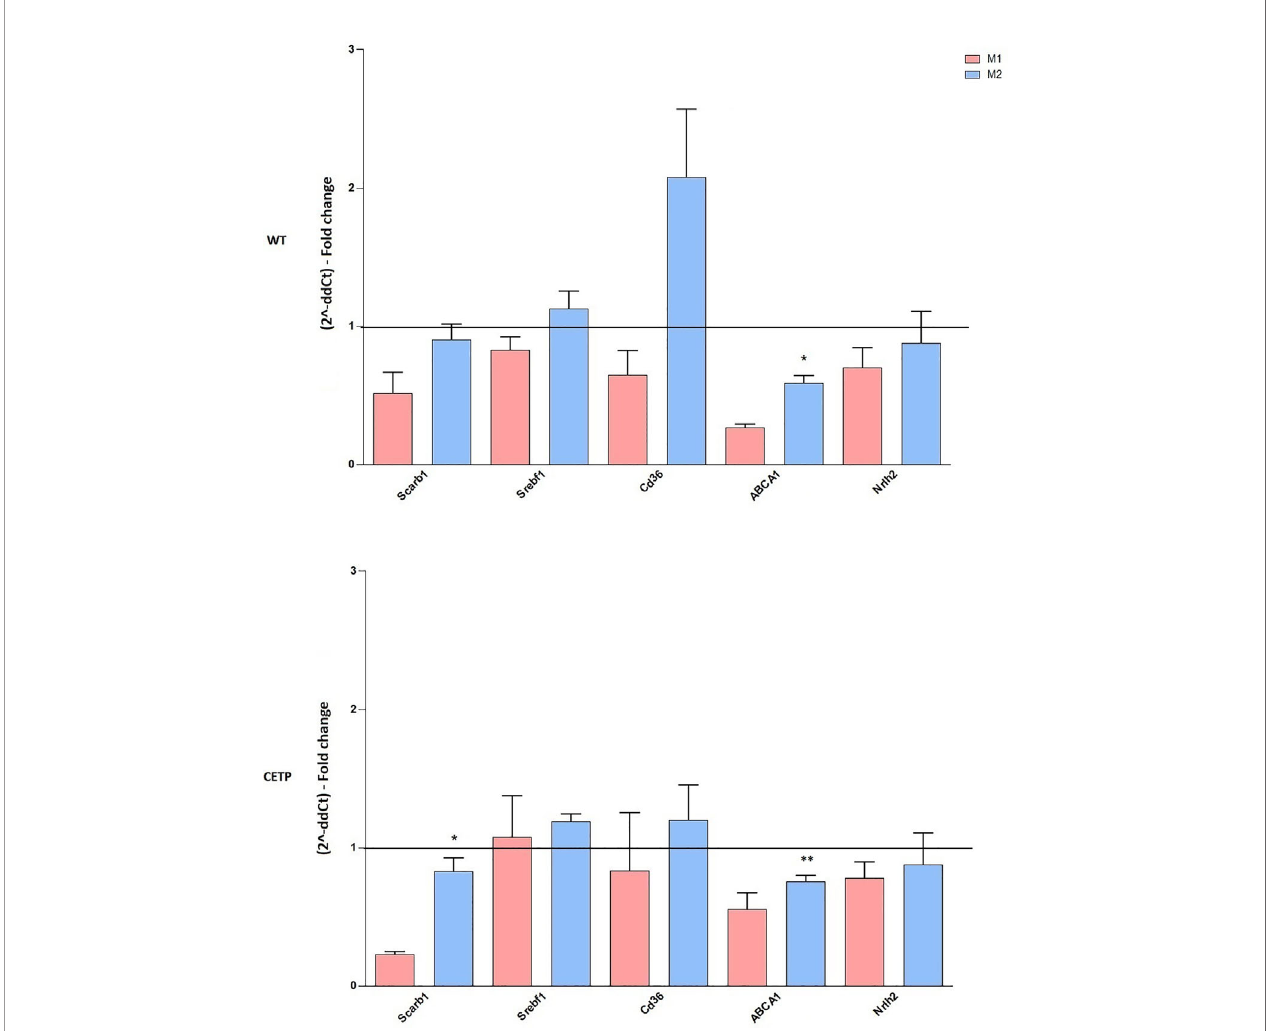
FIGURE 3 | Gene expression of factors associated with lipid metabolism from bone marrow-derived macrophages of WT and huCETP Tg mice. In vitro stimulated M1 (5 ng/ml IFN g + 50 ng/ml LPS) and M2 (10 ng/ml IL-13 + IL-4) for 24 h. mRNA expression was determined using by RT-PCR. Results are expressed as mean ± standard deviation and were compared by unpaired Student ’ s t-test. (n = 3 – 5). *P < 0.05 (M1 vs . M2); **P < 0.05 (CETP M2 vs . WT